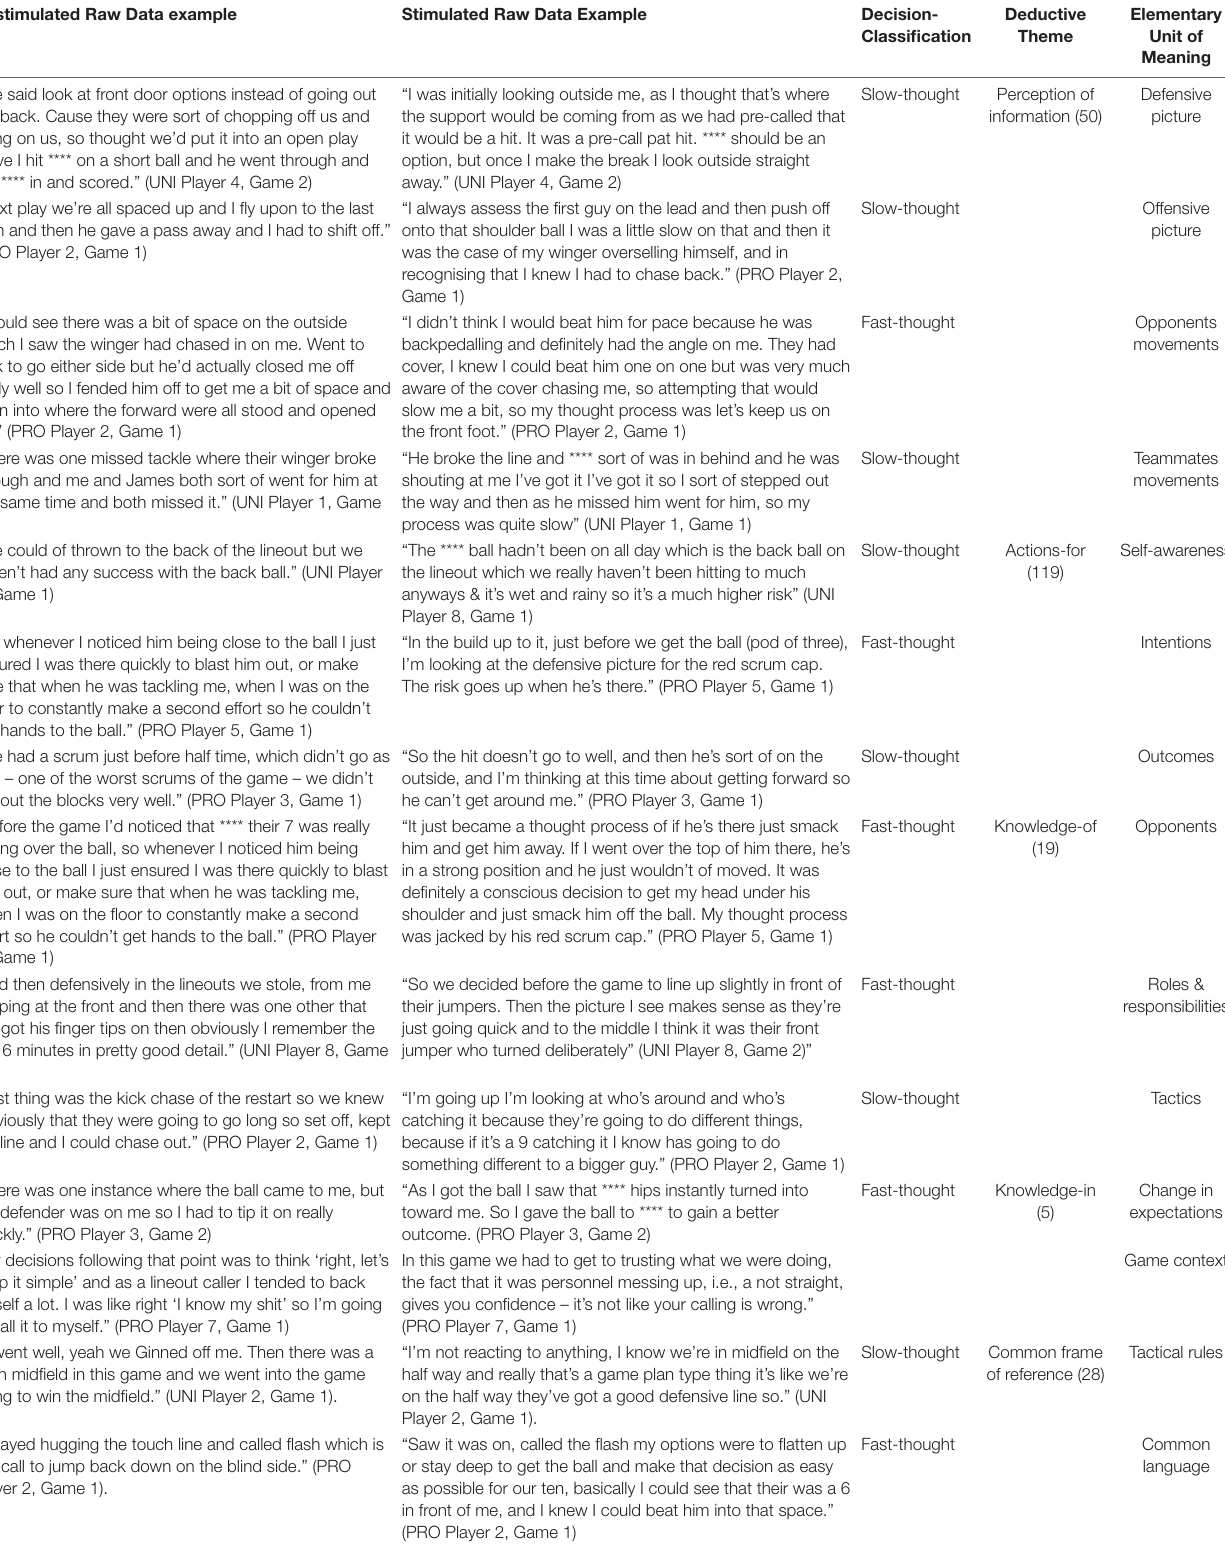
TABLE 2 | Thematic analysis of Unstimulated verbalisations, stimulated verbalisations and decision classifications of the same game moment [ number in brackets denotes the number of player references to this theme ]. Unstimulated Raw Data example Stimulated Raw Data